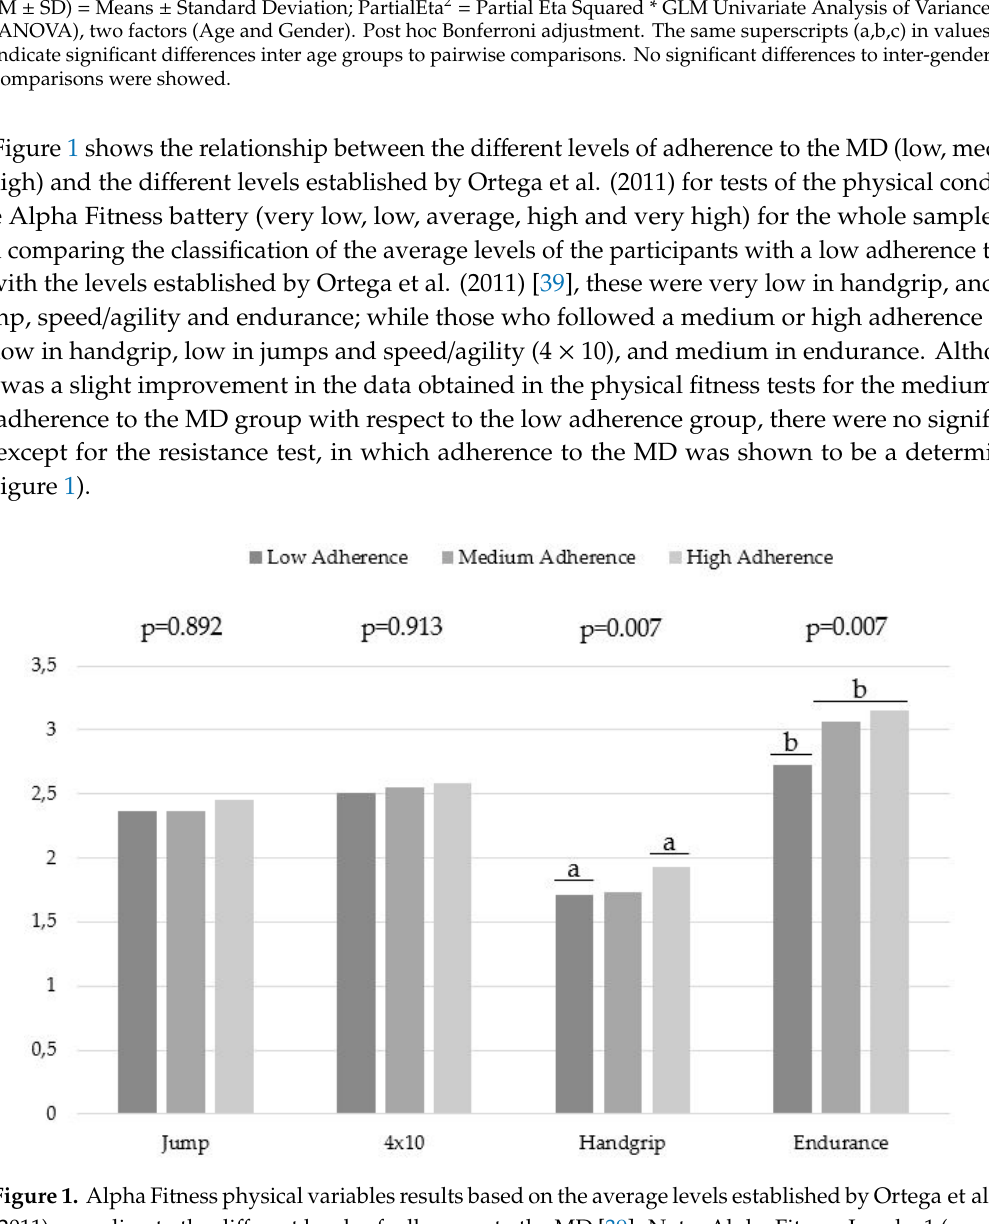
Table 2. Adherence to the MD (KIDMED Index, 0–12 points) by gender and age, (M ± SD). Years Old Total